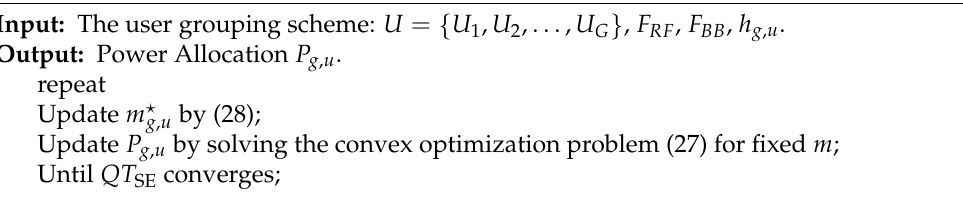
Algorithm 3 The Quadratic Transform Power Allocation Scheme for SE